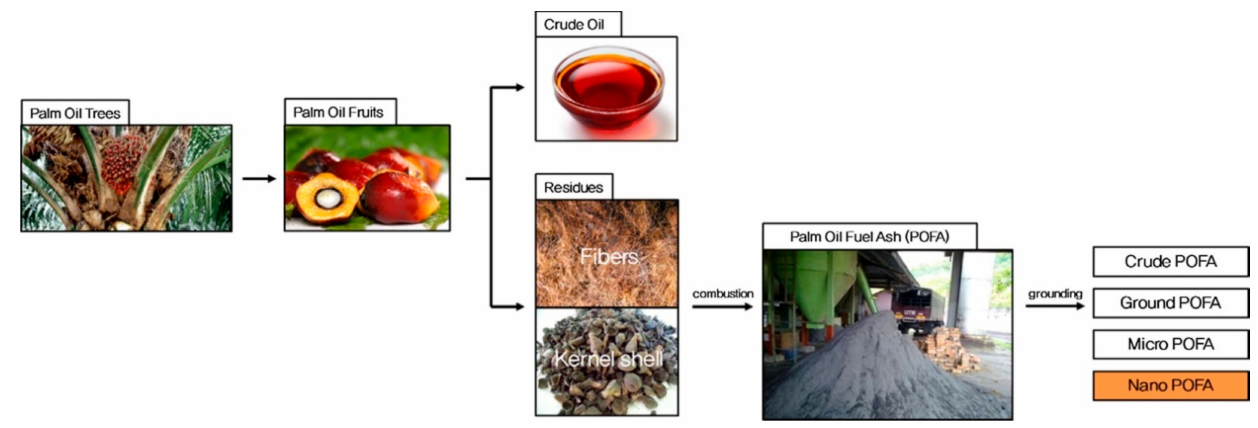
Figure 2. Production procedure of POFA [52]. Reprinted with permission from Elsevier